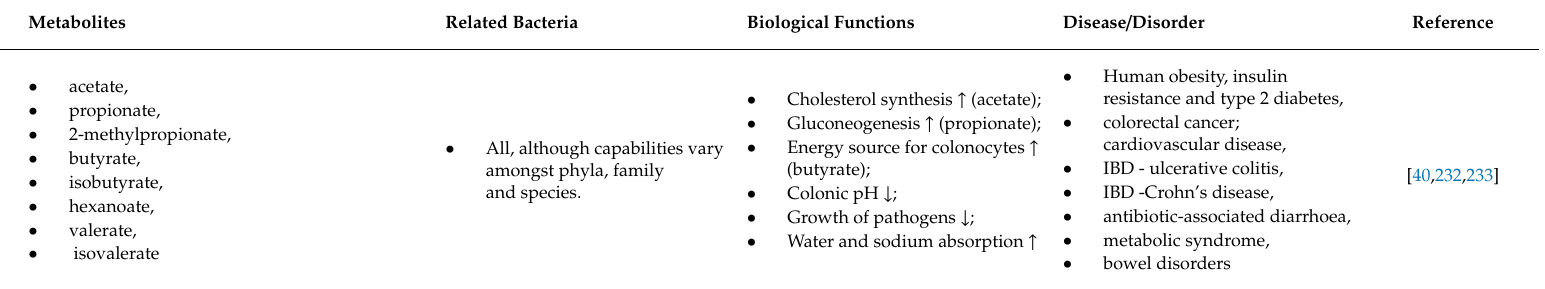
Table 3. Metabolites associated with gut microbiome (modified from [230] and